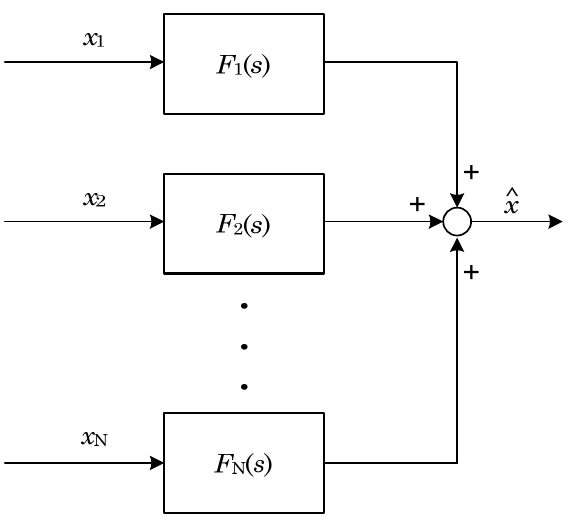
Figure 5. Summation of individual component signals.